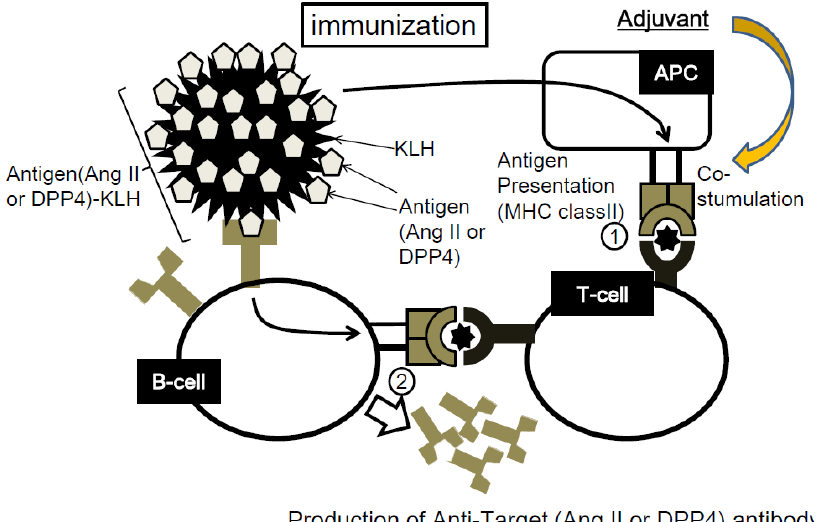
Figure 1. Conceptual schematic of therapeutic vaccine. (Step1) The antigen-presenting cells (APCs) (the antigen, i.e. , Ang II or DPP4, in this case is known as a hapten) phagocytose the antigen-KLH conjugate and present a T-cell epitope of KLH to T-cells through the major histocompatibility complex (MHC). T-cells recognize it through T-cell receptors and become activated. (Step2) B-cells specifically recognizing the target antigen differentiate into plasmacytes and proliferate with the help of activated T-cells. Then, B-cells produce anti-angiotensin II (Ang II) or DPP4